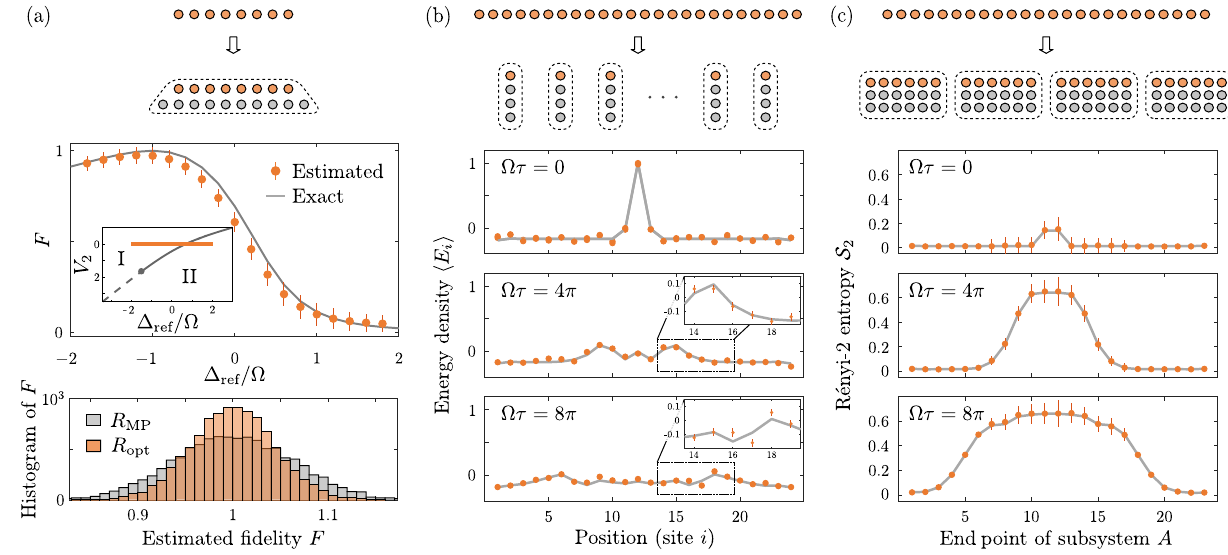
FIG. 6. Extraction of various physical information in a system of interacting Rydberg atoms using our protocol. Rydberg atoms (orange circles) are coupled to ancillary atoms (gray circles) with different interactivities (denoted by the dashed boxes; distance not to scale): only atoms within the same dashed boxes may interact. (a) We apply the global quench setup onto a state believed to be experimentally prepared [Eq. (49)] at parameters ð Δ ; V 2 Þ ¼ ð − Ω ; 0 Þ , and extract its fidelity to several reference states: the ground states of in the ground state of H Ryd ∈ ½ − 2 Ω ; 2 Ω (cid:2) and V 0 . In the upper panel, we compare the fidelity extracted using a single set of m ¼ 2000 samples (orange H at Δ 2 ¼ Ryd ref scatter points) and the exact values (gray solid line). The error bar is the standard deviation of the estimated fidelity over 100 independent sets of m samples. The inset indicates the phase diagram of H reproduced from Ref. [70]. Our considered range of Δ (orange line) covers Ryd ref both the disordered (I) and Z 2 ordered (II) phases. In the lower panels, we compare the distributions for extracted fidelity using the optimal recovery map R [Eq. (38), orange bars] and the state-agnostic Moore-Penrose version R [Eq. (12), gray bars]. We obtain the opt MP distributions by generating 10 4 different sets of m ¼ 2000 samples and estimate the fidelity from each set. Note that the extracted fidelity need not be bounded above by one because the recovery map is generally not positive, and may map each measurement snapshot to an has a provably smaller variance, as corroborated by the numerics, and hence, a smaller unphysical state. The optimal recovery map R opt sample complexity than R . (b) We extract the local energy density h E [Eq. (51)] after a local perturbation in the middle of the chain using i i MP a patched quench. This can be done by “ fanning out ” the atoms of the system into well-separated patches and coupling each of them to their own ancillary atoms. The insets enlarge into values of the local energy density on sites 14 to 19. The extracted values (orange scatter points) from m ¼ 2000 samples agree well with their exact values (gray solid line) and correctly capture the energy diffusion at all times τ after the perturbation. (c) We extract the R´enyi-2 entanglement entropy after the perturbation, using patched quenches with m ¼ 10 5 samples. The error bar increases substantially when the subsystem A overlaps with multiple